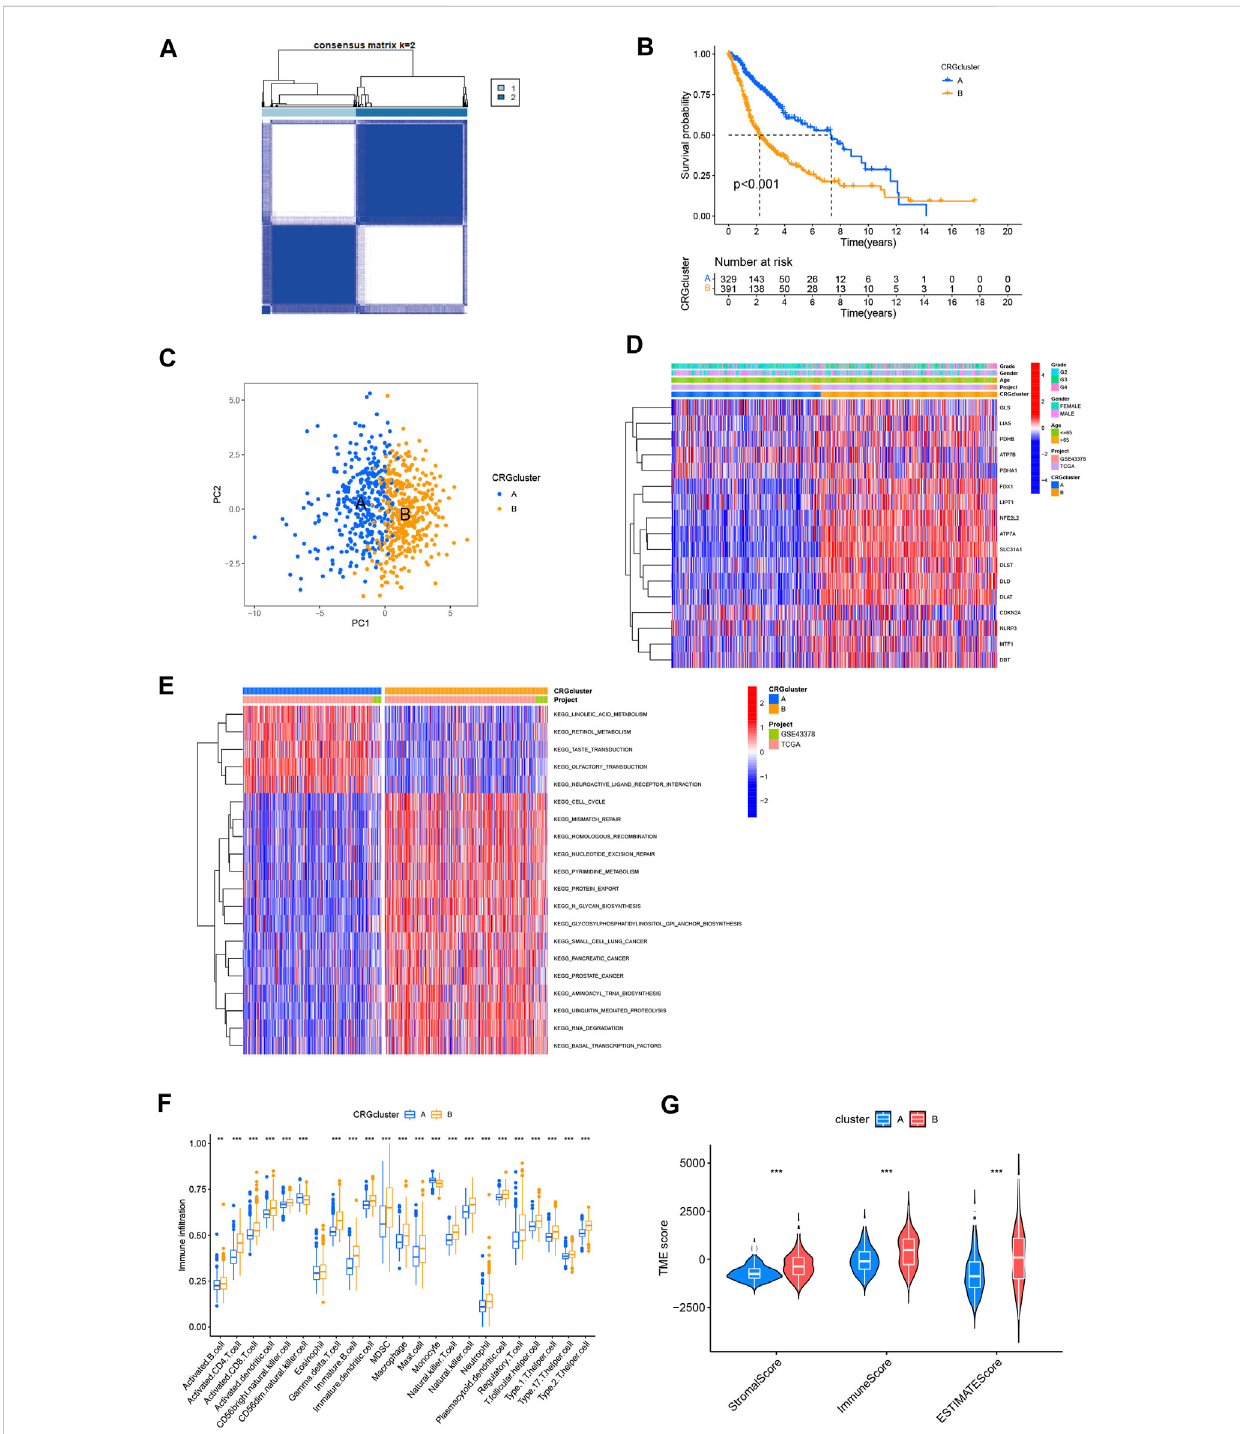
FIGURE 3 Analysis of cuproptosis subtypes. (A) Consensus clustering algorithm heatmap with k = 2. (B) Kaplan-Meier analysis of 2 subtypes. (C) PCA analysis. (D) Heatmapbasedoncuproptosis-relatedgenesexpressionandpathologycharacteristicsbetween2subtypes. (E) GSVAanalysisofcuproptosis-related genes subtypes with red represent activated pathway and blue inhibited. (F) ssGSEA analysis of these 2 subtypes. (G) TME score of 2 subtypes. (* p < 0.05; ** p < 0.01; *** p <